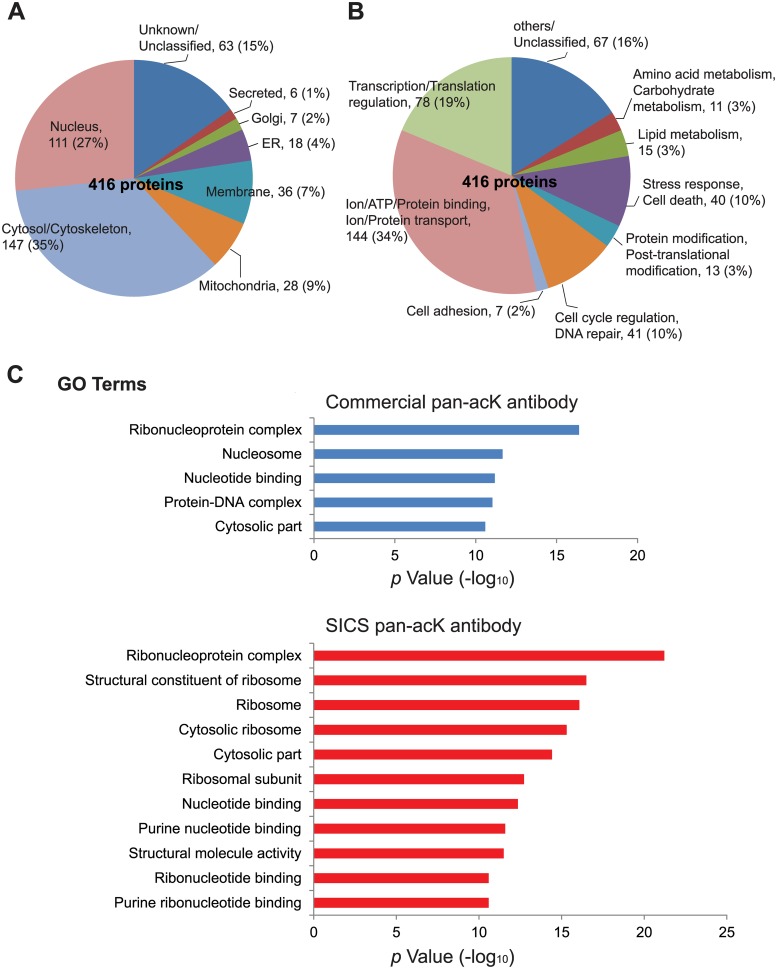
Classification and gene ontology of acetylated proteins.Acetylated proteins identified by LC-MS/MS after immunoprecipitation with both the commercial and SICS pan-acK antibodies were classified by their subcellular localization (A) and molecular function (B). (C) The most significant (p value (-log10) > 10) GO terms for the acetylated proteins identified by either the commercial or the SICS pan-acK antibodies.